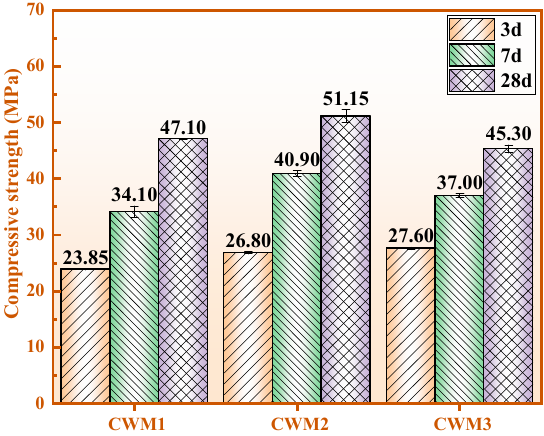
Figure 4. Compressive strength of the three CWMs.